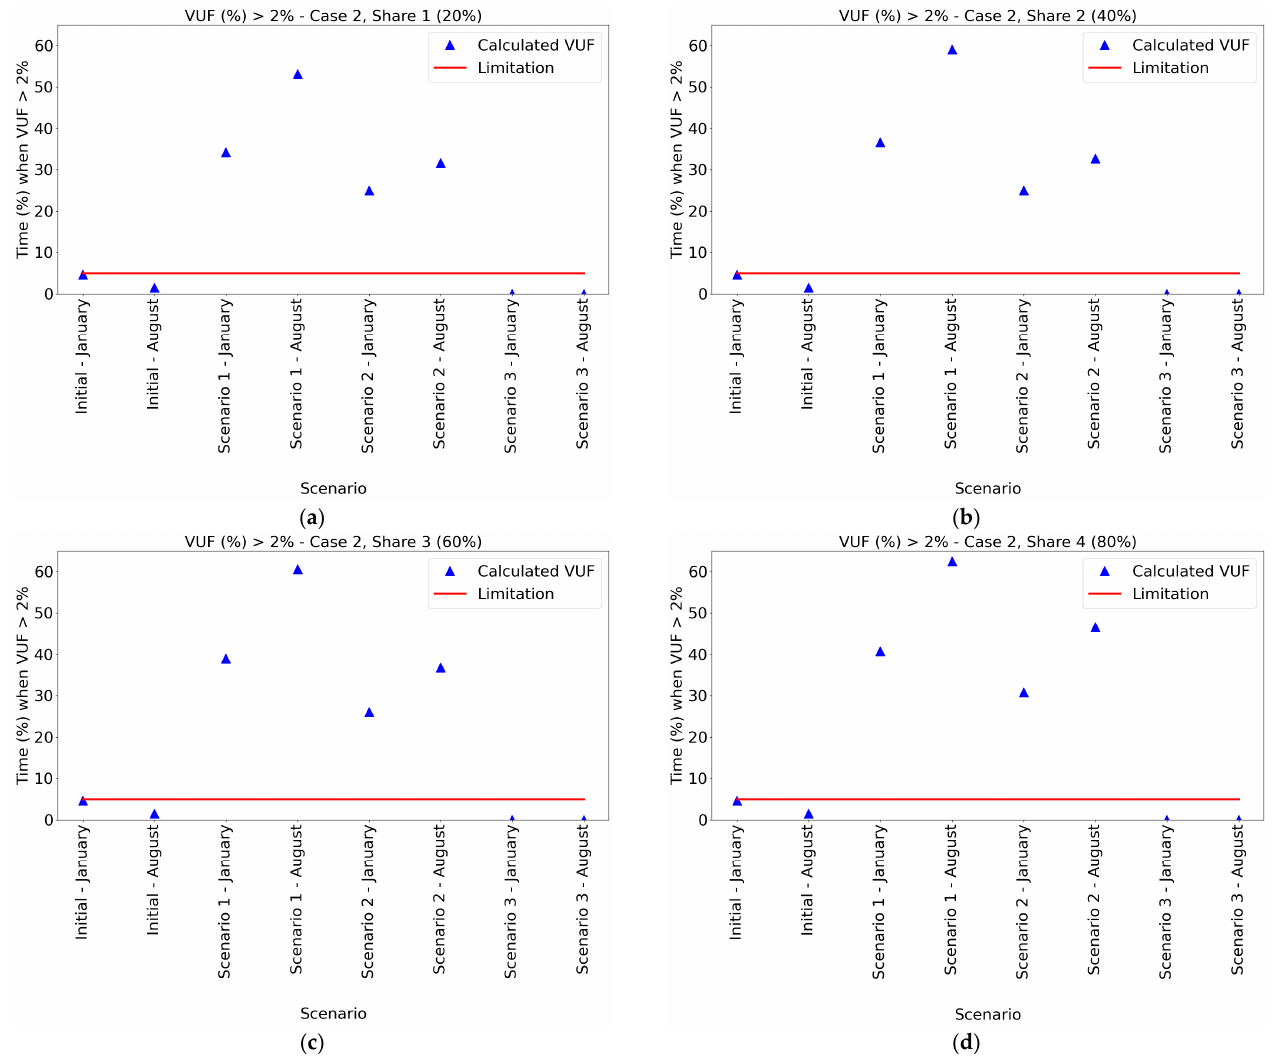
Figure 5. VUF > 2%—Case 2; Share 1–Share 4; January,